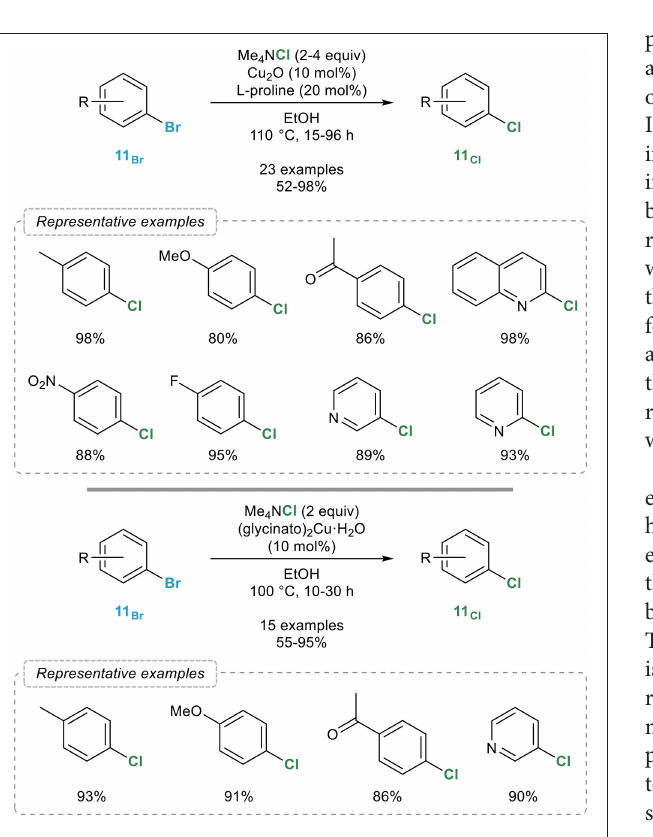
FIGURE 10 | Copper-mediated/catalyzed aromatic retro-Finkelstein